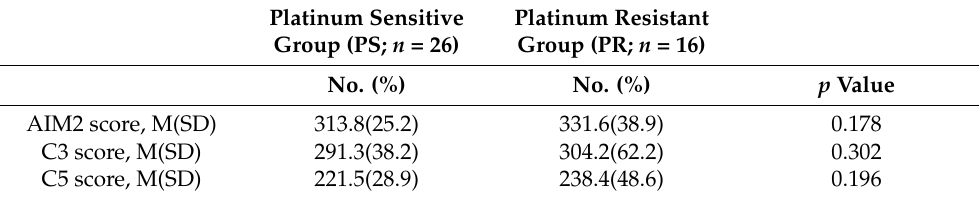
Table 2. Association between platinum sensitive/resistant and putative